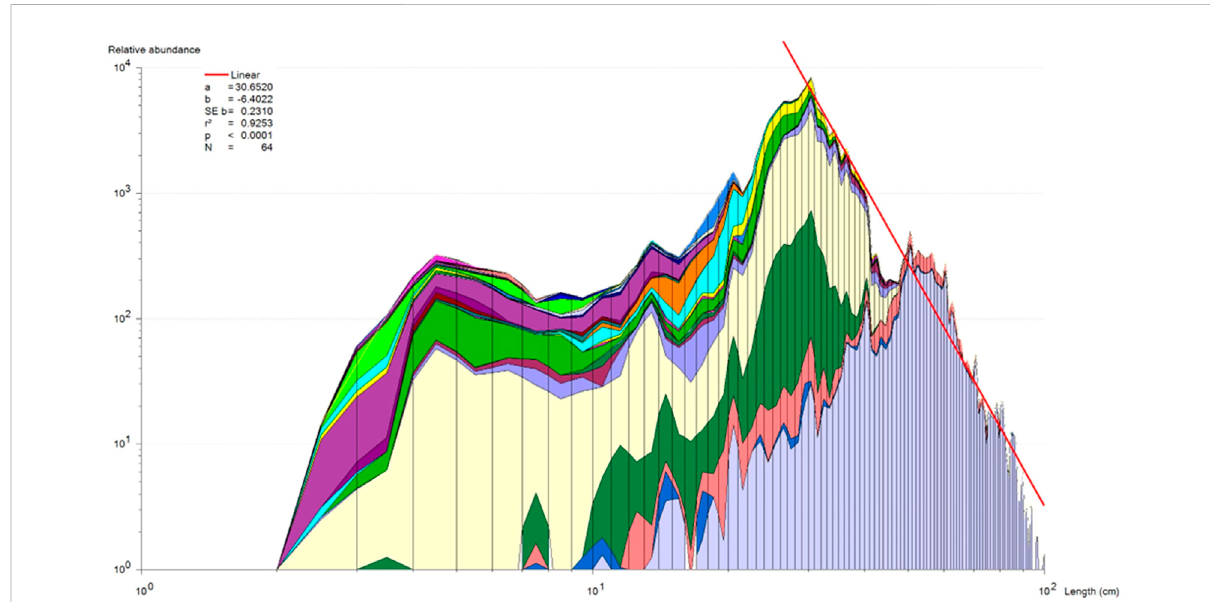
FIGURE 4 Relativebiomass-sizedistributionoftheOkavangoDelta fi sheryrepresentedbycumulatedstandardized(numbercaughtpergearsample)log- log converted catch-curve in the seven most frequently encountered fi shing methods (see Figure 3). The slope of thecatch curve from 28 cm TL to 100 cm TL is almost identical ( p = 0.073) to the theoretical undisturbed Sheldon spectrum slope of − 6, which indicate that the fi shery is pretty balanced in this size range, consisting of mainly cat fi shes, tiger fi sh and larger cichlids. Species and sizes below 28 cm TL are relatively underutilized in terms of a fully balanced fi shery (Source: Mosepele,